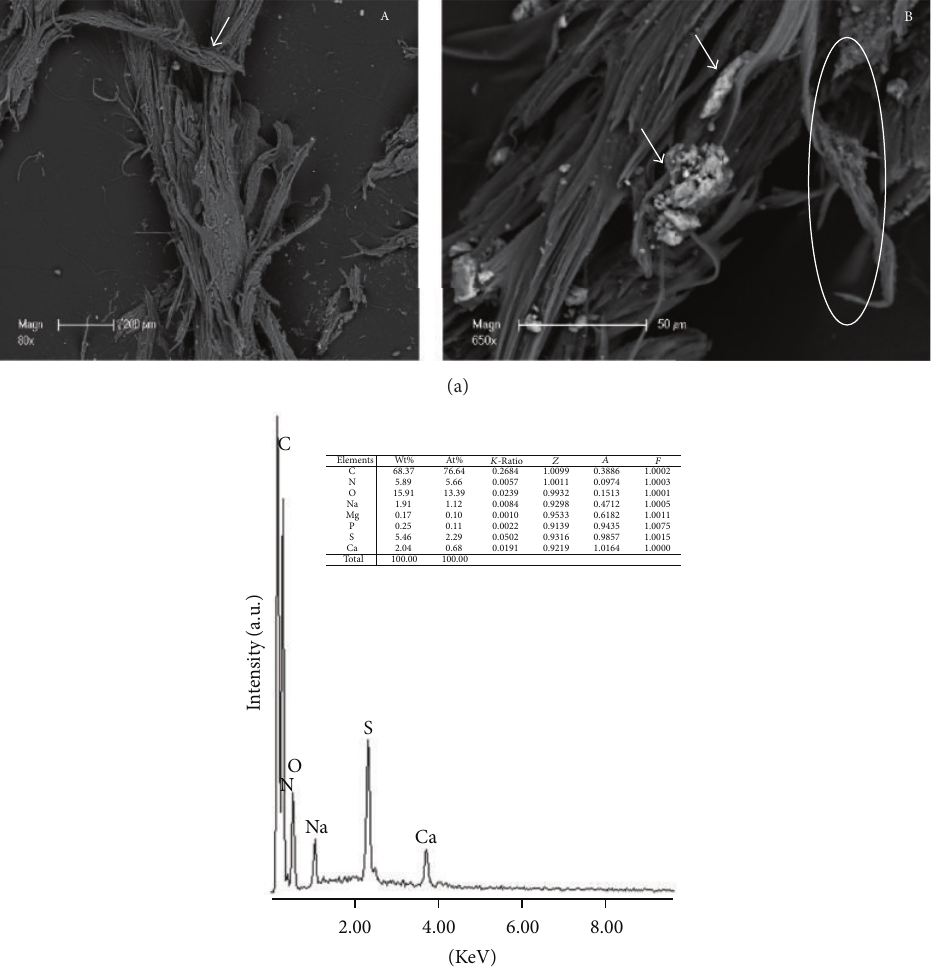
Figure 2: (a) SEM images of AKU aortic valve . (A) Ultrastructural features of typical filiform (arrow) Lambl’s excrescences and massive desquamation of superficial layers are reported. (B) Tissue fibers adjacent to calcium deposits interconnecting bundles of collagen and evident defects on the valve surface disrupting the endothelial cover are shown. Arrows indicate hydroxyapatite concretions. Circles highlight calcium deposits interconnecting bundles of fibrous tissue. (b) EDS spectra of pigmented area of AKU aortic valve . Table reports ochronotic pigment element